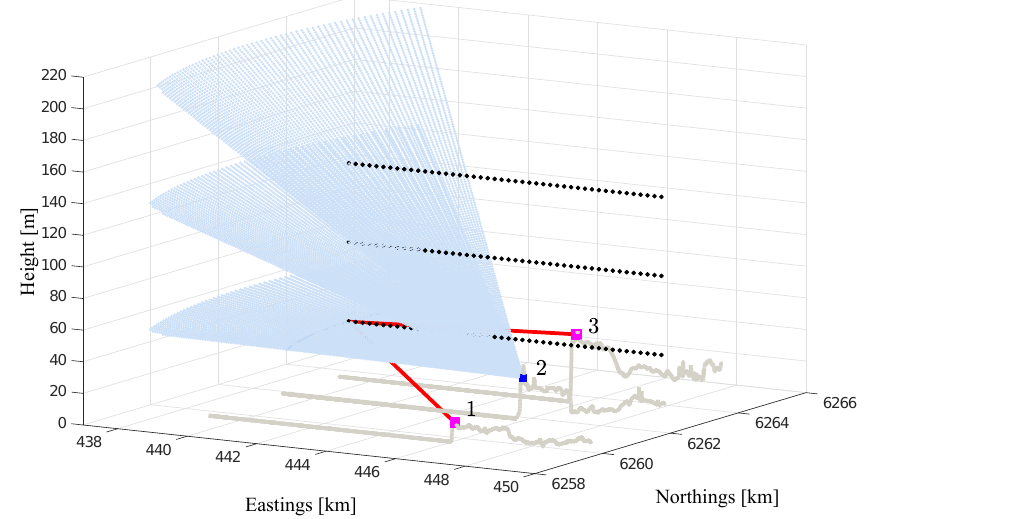
Figure 2. Scanning trajectories of the dual-set-up (black dots) and the PPI (light blue points) scenarios. The red lines show two laser beams from the dual-set-up lidars (magenta boxes) focusing at position 7 (see Fig. 1). The grey lines indicate the terrain height above sea